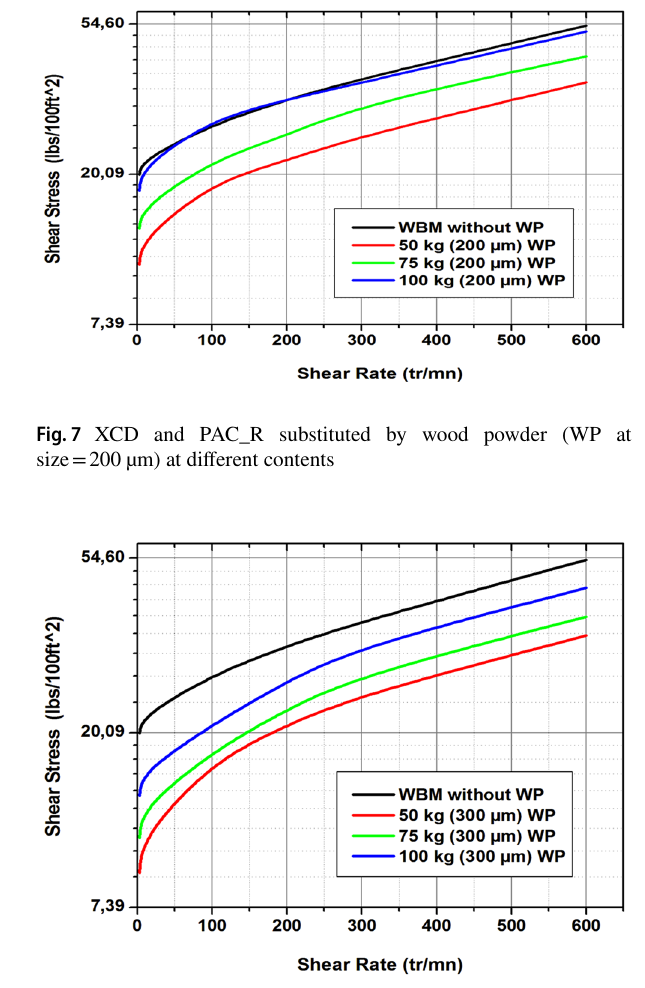
Fig. 8 XCD and PAC_R substituted by wood powder (WP at size = 300 µm) at different